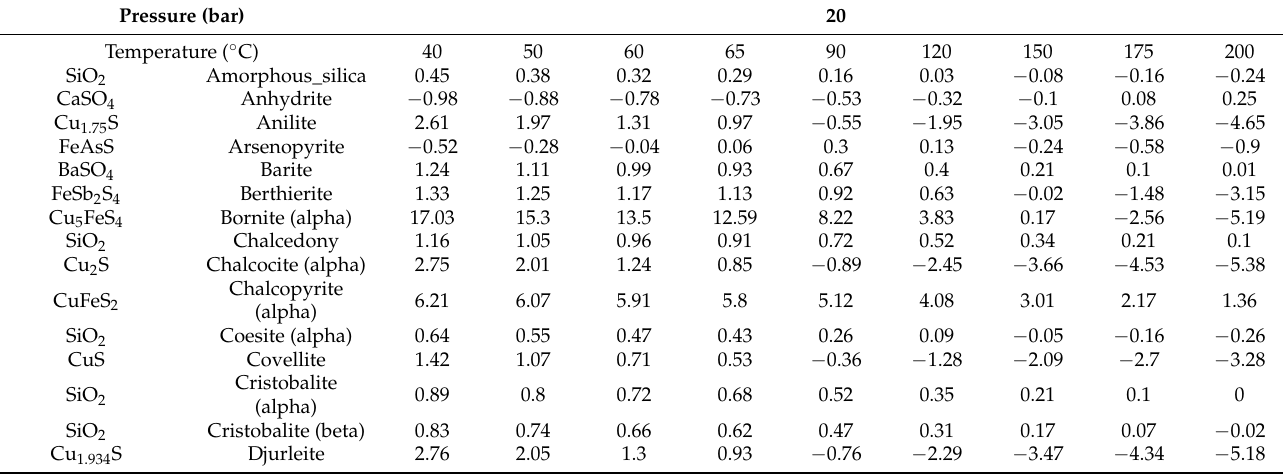
Table A1. Saturation Index of minerals with potential to